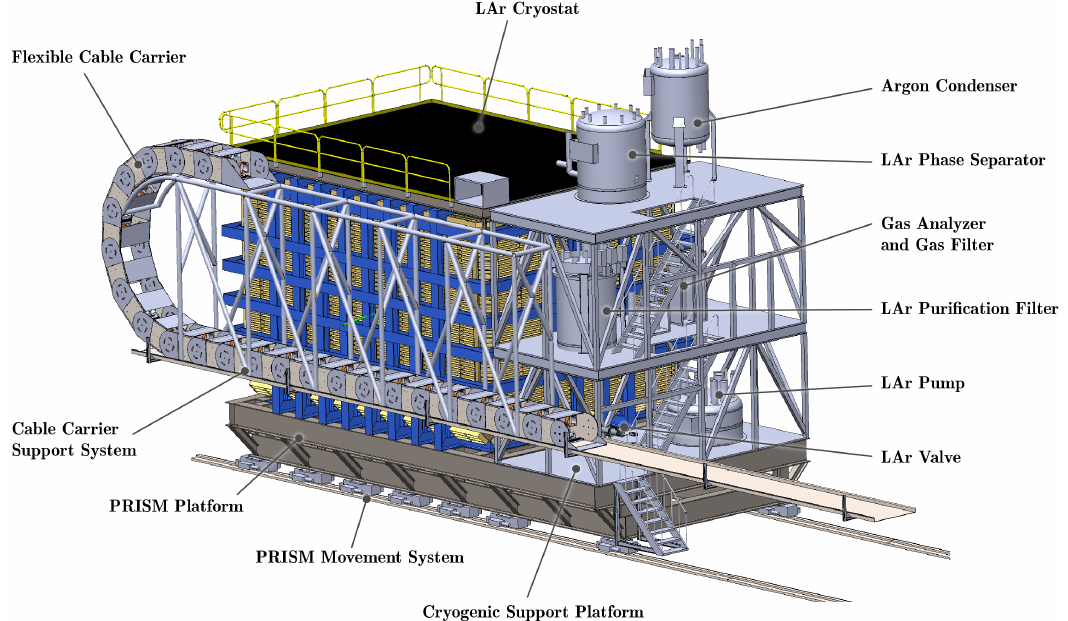
Figure 171. Illustration of the ND-LAr subdetector setup including the cryostat, the cryogenic purification system, and the PRISM movement system. A large cable carrier houses flexible cryogenic pipes, power, and data acquisition cables. ND-GAr will have a similar, separate cable